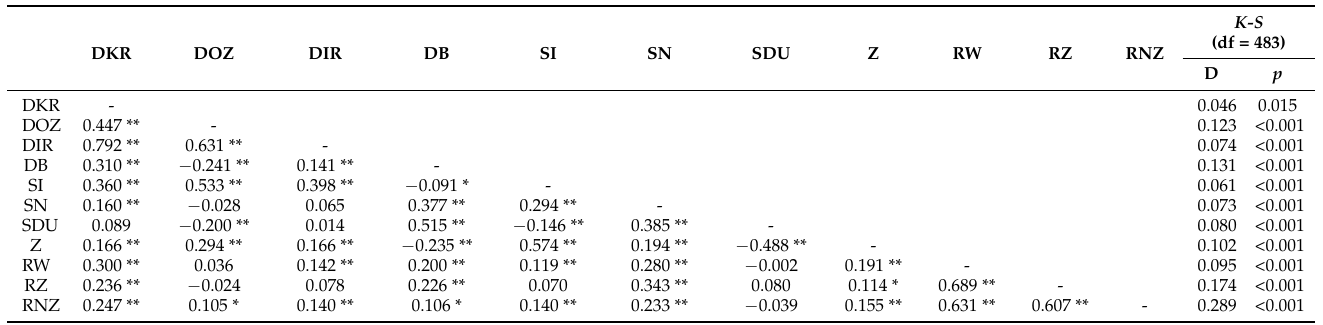
Table 1. Kolmogorov–Smirnov test and Pearson’s r correlation matrix between religiosity (DUREL), identity styles (ISI-5), and readiness to enter interreligious dialogue